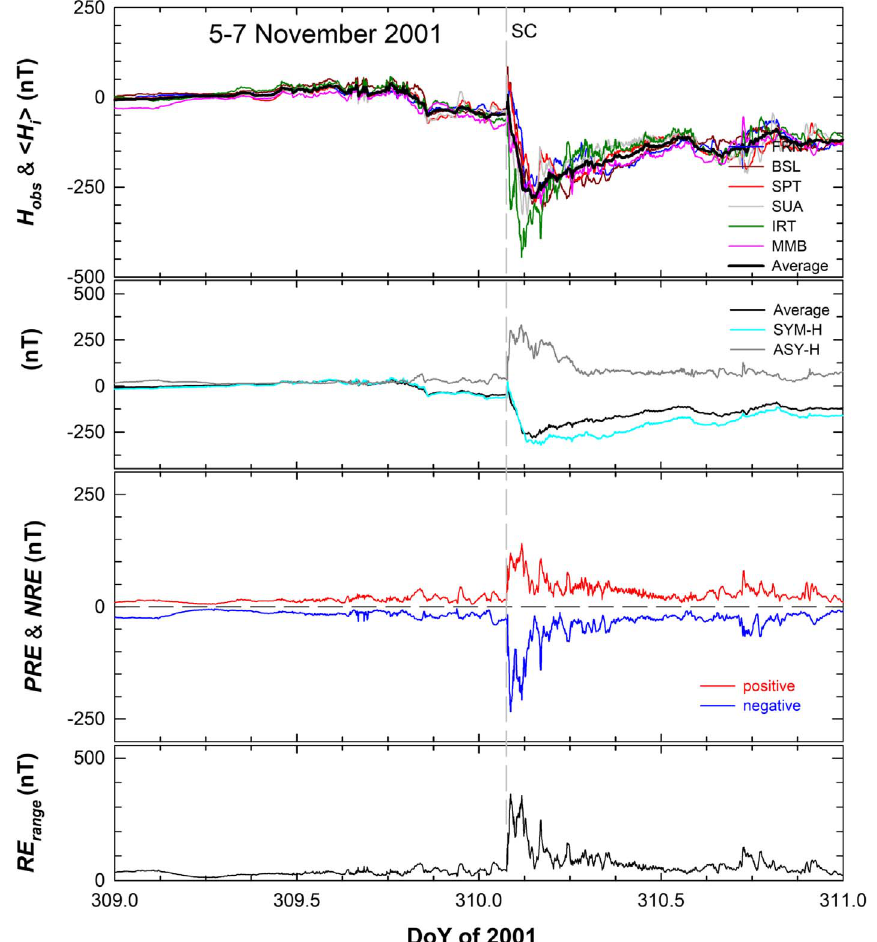
Fig. C.4. The event on 5 – 7 November 2001 (event